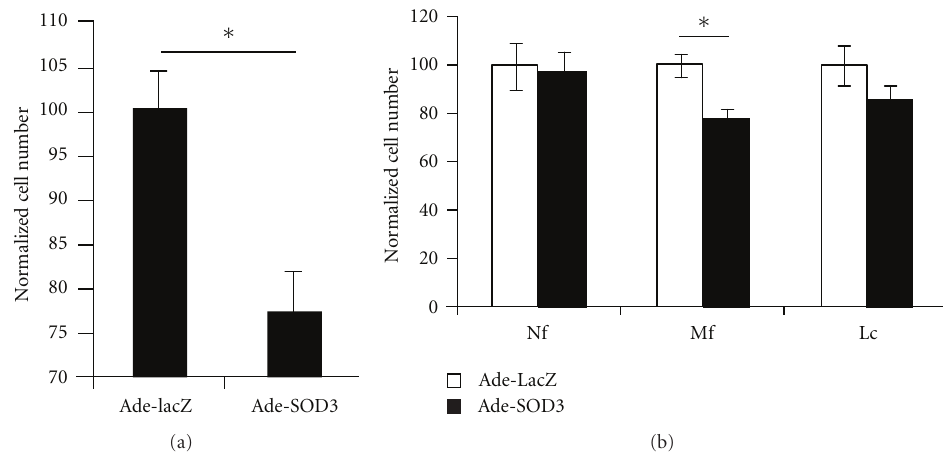
Figure 4: Peritonitis is limited by SOD3. Ade-SOD3-treated mice had less peritoneal infiltrating cells after peritonitis induction with proteose peptone and IL-1 β than Ade-LacZ-treated control mice (a) ( n = 5). The reduction in cell number was mainly due to diminished peritoneal macrophage population (b) (Nf = neutrophil, Mf = macrophage, Lc = lymphocyte).